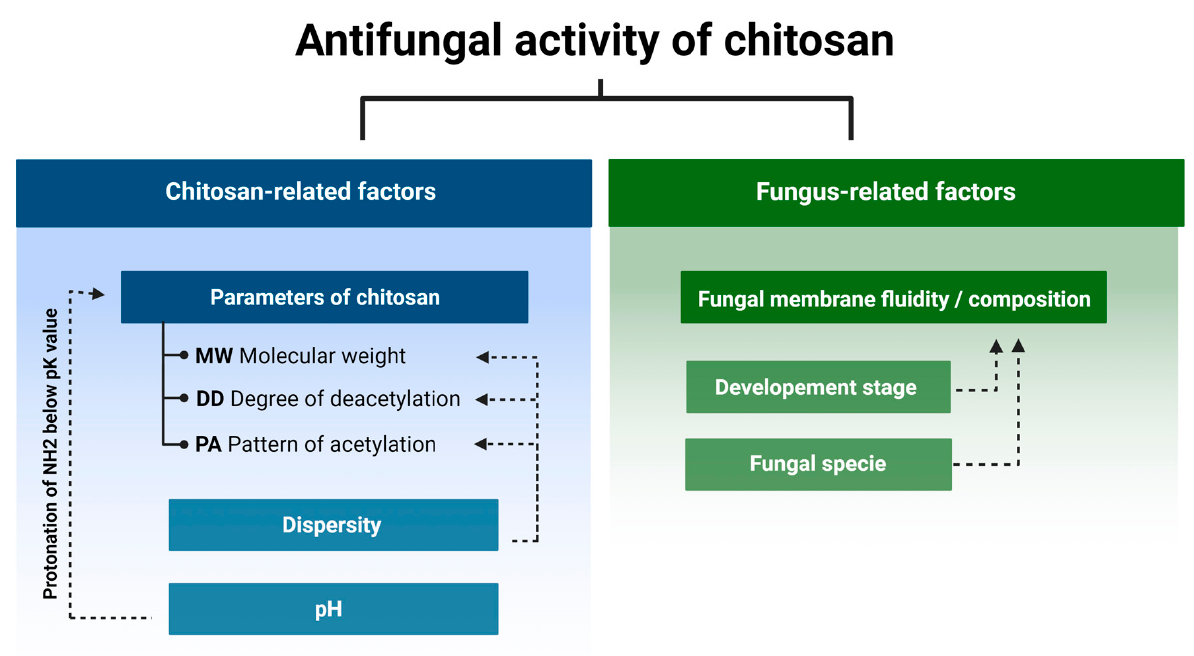
Figure 2. Chitosan and fungus-related factors that affect the antifungal activity of chitosan.